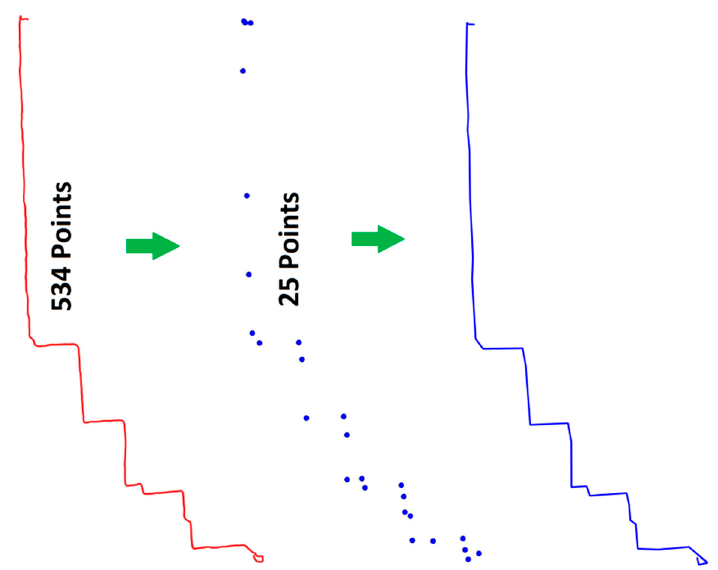
Figure 16. Number and location of extracted critical curvature and turning points.